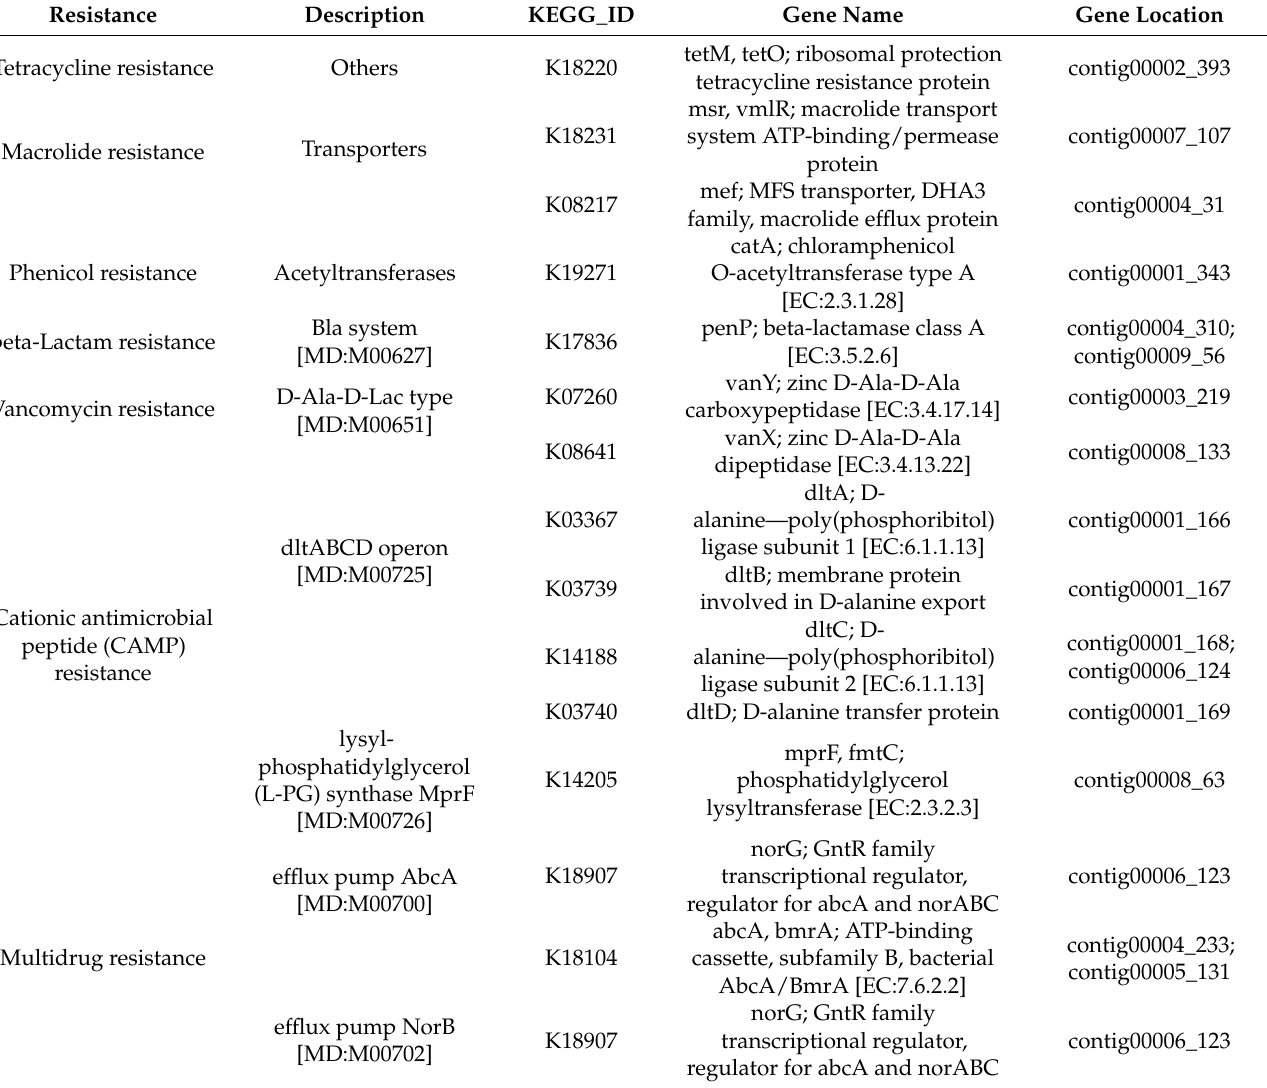
Table 7. AMR (antimicrobial resistance) genes identified and their location in the Lactiplantibacillus plantarum DJF10